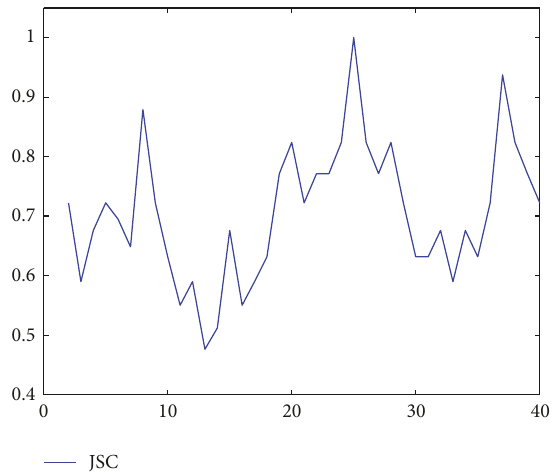
Figure 9: JSC values for the MaxSTs in sliding windows.